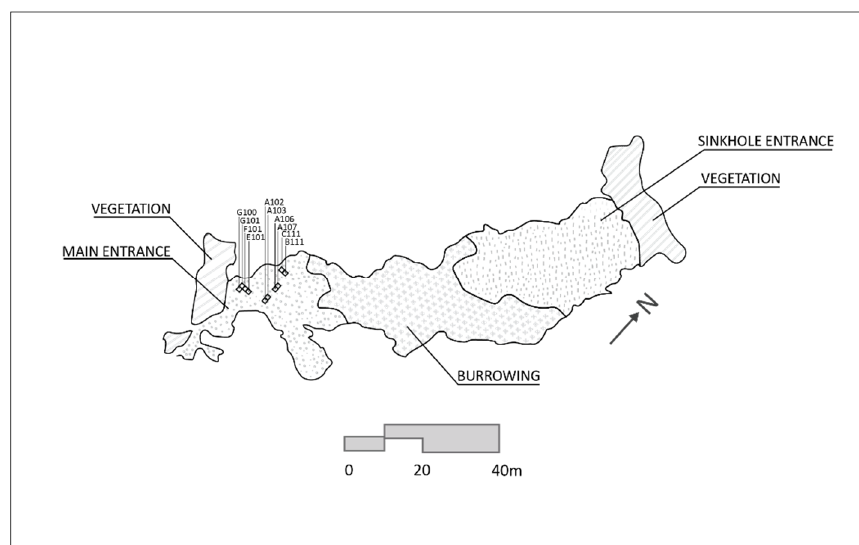
Figure 3. Site plan showing location of squares .